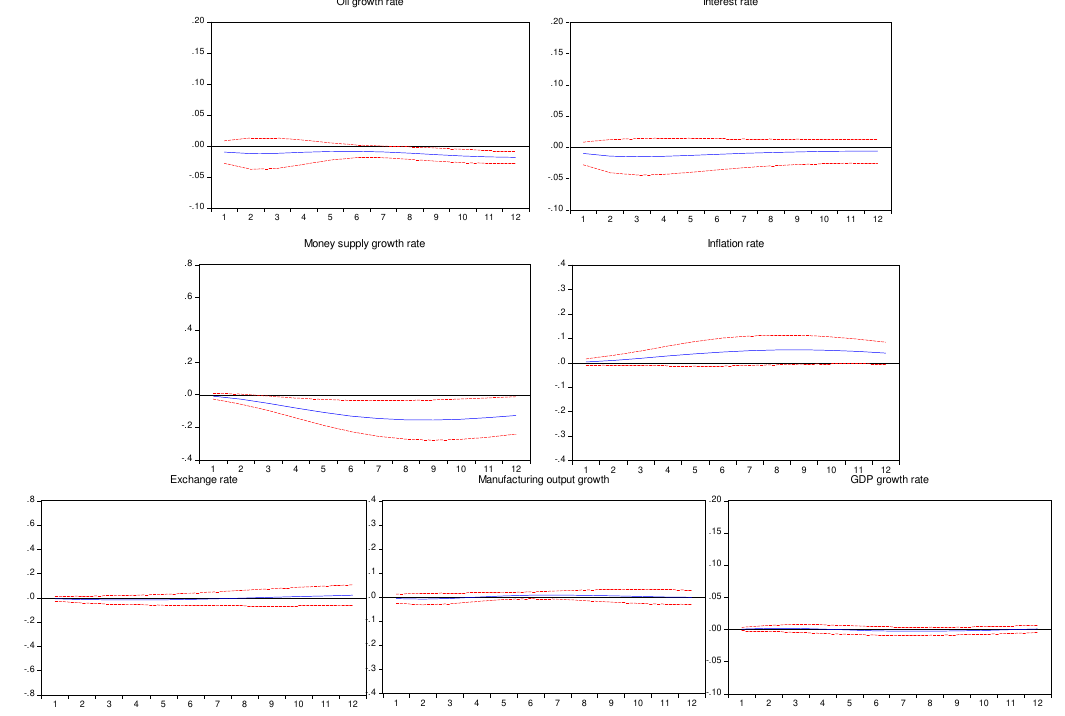
Figure 1. Responses of selected variables to oil price shocks in